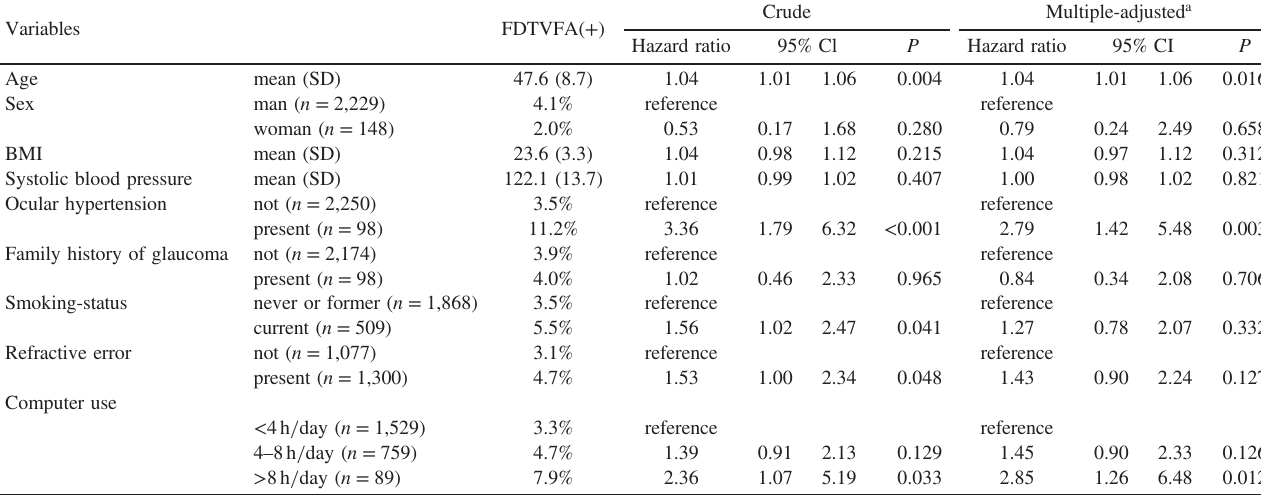
Table 2. Univariate and multivariate analysis of the risk factors for FDT-VFA